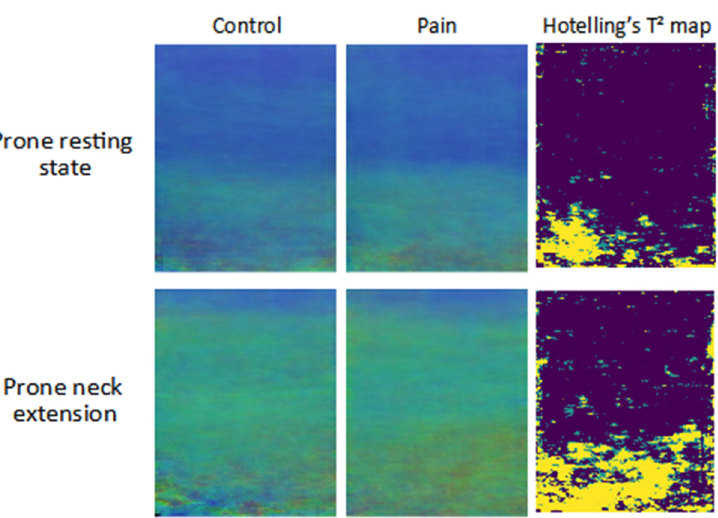
Figure 4. Summary mean images of the elastograms’ RGB values comparison between resting and active state of prone neck extension; Hotelling’s T 2 test map—green color p -value < 0.05—yellow color p -value < 0.01.